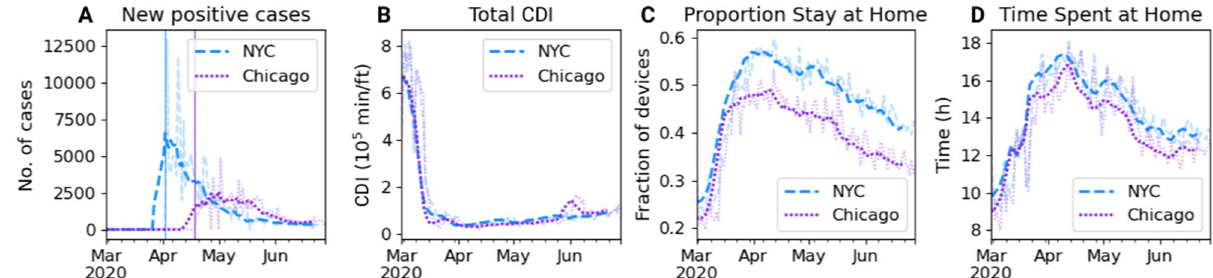
Figure 2. Trends of cases and mobility measures. Daily variation of ( A ) new positive cases, ( B ) contact density index, ( C ) fraction of devices registered as staying at home all day, ( D ) median time spent at home. The light shaded curves denote the daily trends while the dark ones depict their 7-day forward-shifted moving average. The vertical lines in panel ( A ) represent the first dates of available data of the number of cases.